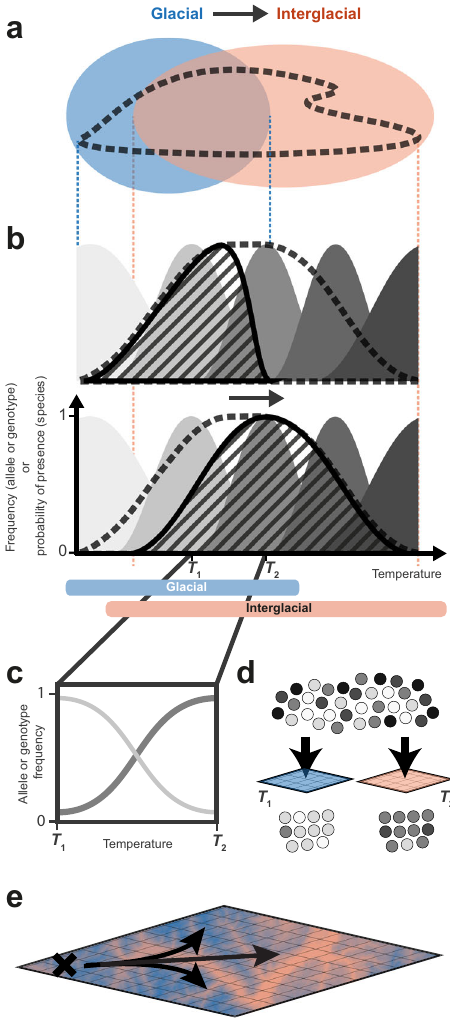
Fig. 1 | Conceptual mechanism for an adaptive response during a range shift. A A shift from glacial to interglacial climate leads to a shift in the overlap of a species ’ fundamentalniche(therangeofenvironmentalconditionstoleratedbythe species; dashed contour) with the period ’ s available environmental space (the rangeofenvironmentalconditionsexpressedinacertainareaandtime;blueellipse – glacial, pink ellipse - interglacial). B The species ’ realised niche (striped curve), re fl ecting this overlap, hence shifts between glacial (top) and interglacial (bottom) periods, constrained by the species ’ fundamental niche (dashed outline). Impor- tantly, rather than uniform entities described by a singular niche, species may comprise multiple genotypes, each with their own, potentially different, environ- mental niche (multiple grey-shaded curves). C Climate shifts, e.g., re fl ecting novel climatic conditions encountered by the species during post-glacial range shifts or expansions,thusactdifferentlyondifferentgenotypes;changingtheirfrequencies. D This fi lters or ‘ sieves ’ particular genotypes (alleles) from the pool of standing geneticvariationdependingonthelocalenvironment. E Asthespeciesexpandsout of a refugia (black cross) and across an environmentally-heterogenous landscape, this drives an adaptive response via the spatio-temporal sieving of climate- associated